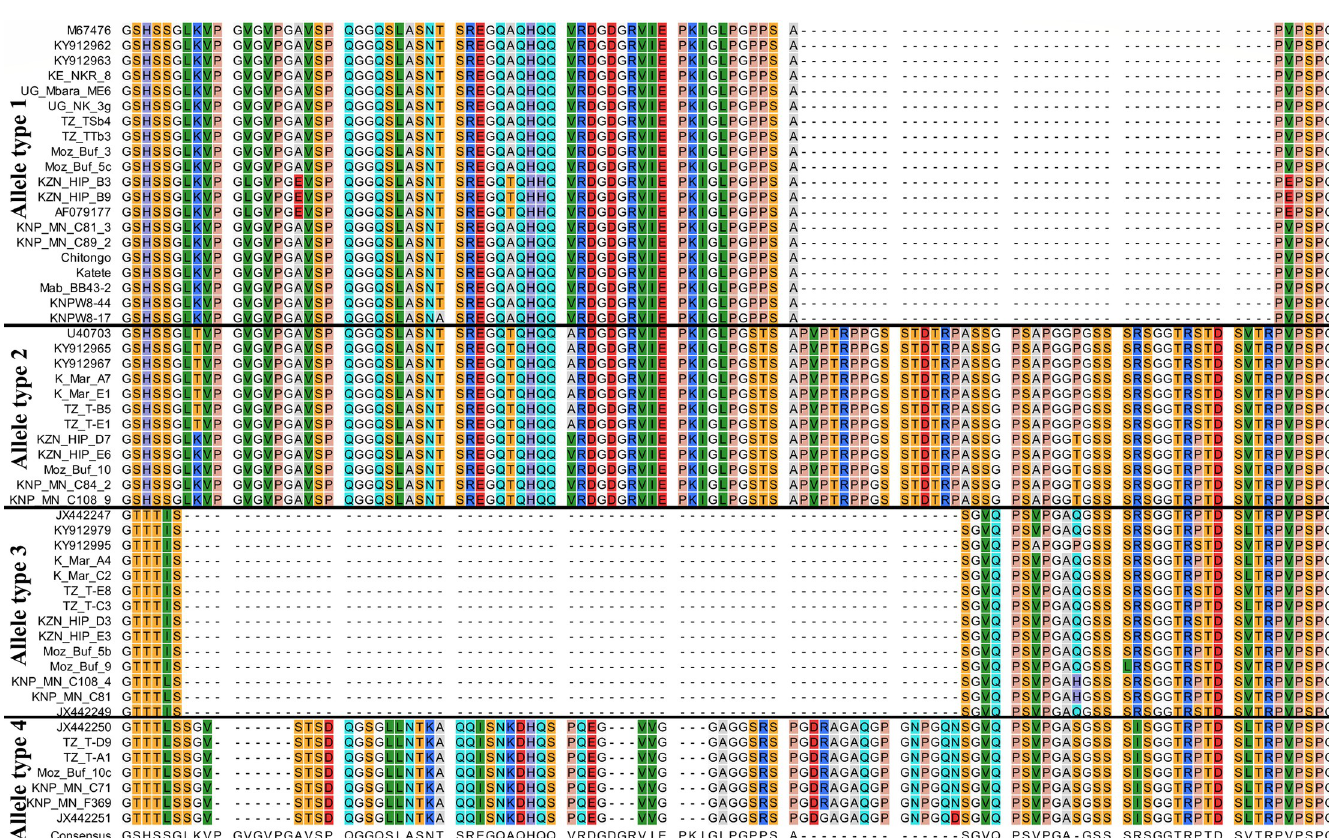
Fig 1. An alignment of p67 sequences from cattle- and buffalo-derived T . parva parasites. Kenya cattle (KE_NKR), Kenya buffalo (K_Mar), Uganda-Mbarara cattle (UG_Mbara), Uganda-Karamoja cattle (UG_NK), Tanzania-Tanga cattle (TZ_TT), Tanzania-Simanjiro cattle (TZ_TS), Tanzania buffalo (TZ_T), Mozambique buffalo (Moz_buf), KZN buffalo (KZN_HIP), CD clinical cases (KNP_MN_C), non-clinical T . parva -positive case (KNP_MN_F369) and reference